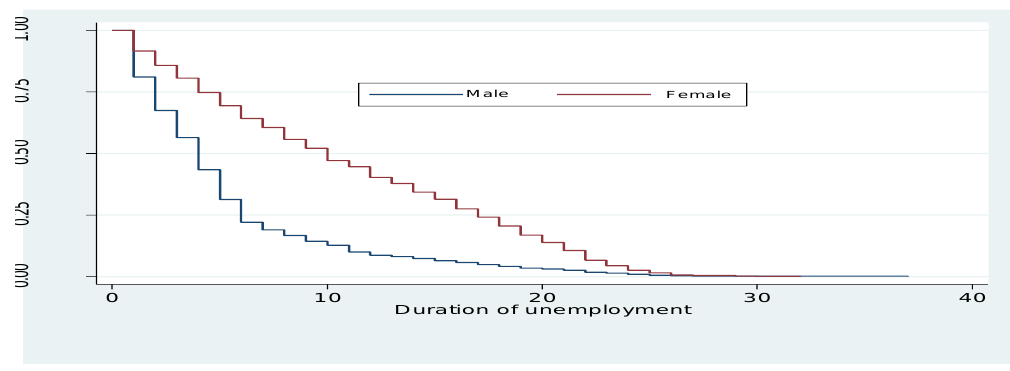
Figure 16: Survival function by